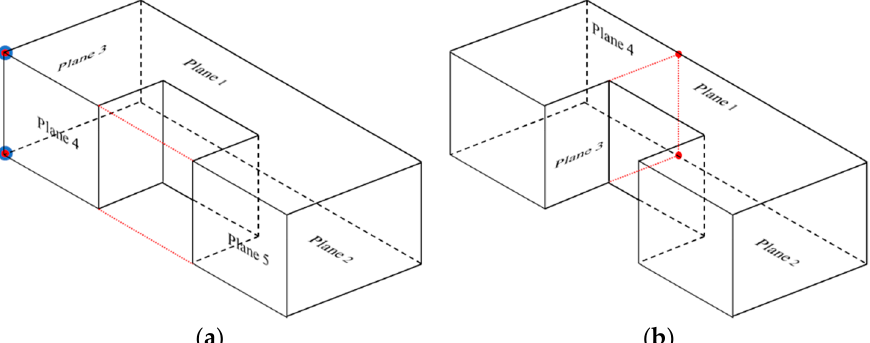
Figure 4. Exceptions of Intersected Planes: ( a ) intersection of Planes 4 and 5 with Plane 3 and floor/ceiling (Planes 2 and 1, respectively) result in coincident intersection points; ( b ) intersection of Plane 3 with Plane 4 generates virtual points in floor (Plane 2) and ceiling (Plane 1).